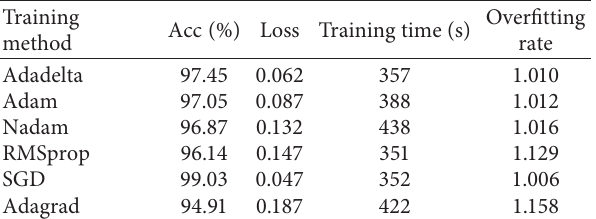
Figure 14: Comparison of training loss value with different dropout values. Table 5: Effect of different dropout values on the training effect of deep reconstruction network